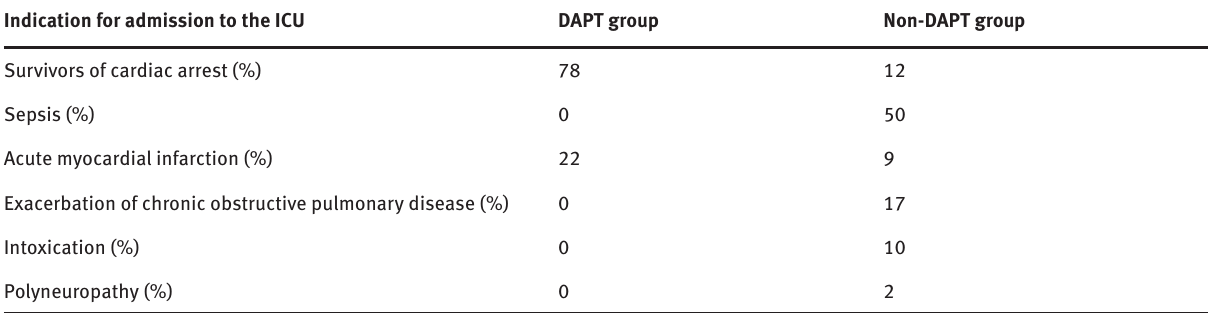
Table 1: Indications for admission to the